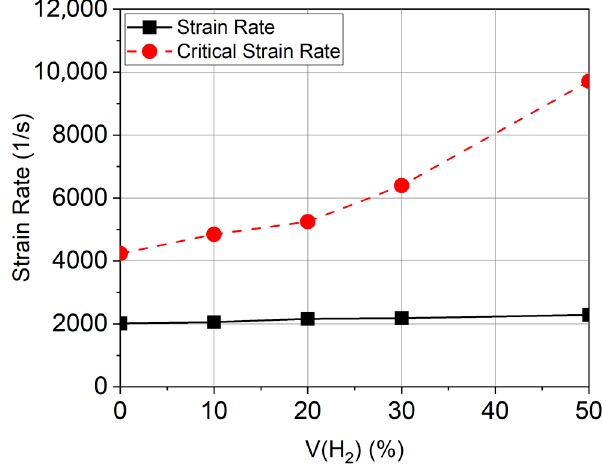
Figure 26. Change in the critical strain rate in the flame and the strain rate in the flow with a change in the hydrogen volume fraction in the fuel [34].